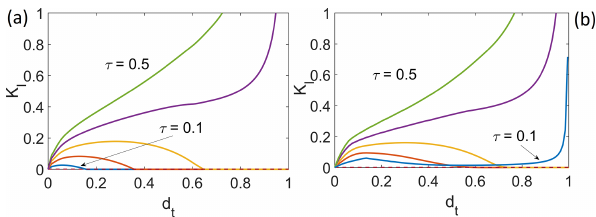
Figure 5. (a) Stress intensity factor versus the crack length for large-scale extensional stress, τ = 0 . 1 (blue), τ = 0 . 2 (orange), τ = 0 . 3 (yellow), τ = 0 . 4 (purple) and τ = 0 . 5 (green) for (a) η = 0 . 6 and (b) β = 0 . 01, both computed with the contact constraints being